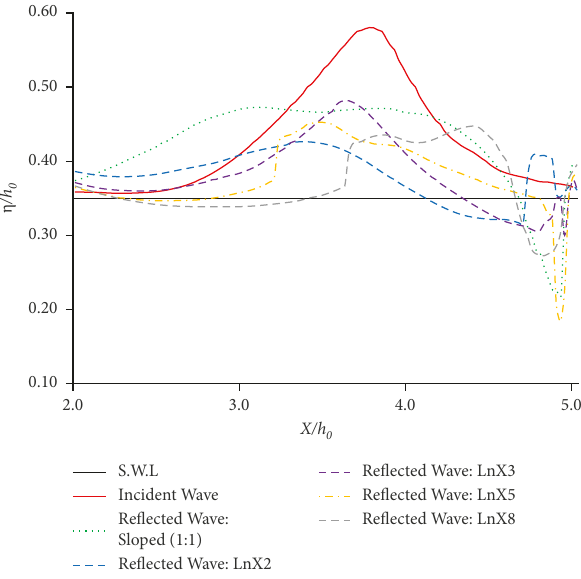
Figure 18: The incident wave and relevant reflected waves from sloped and logarithmic walls ( H / h 0 : 0.7).